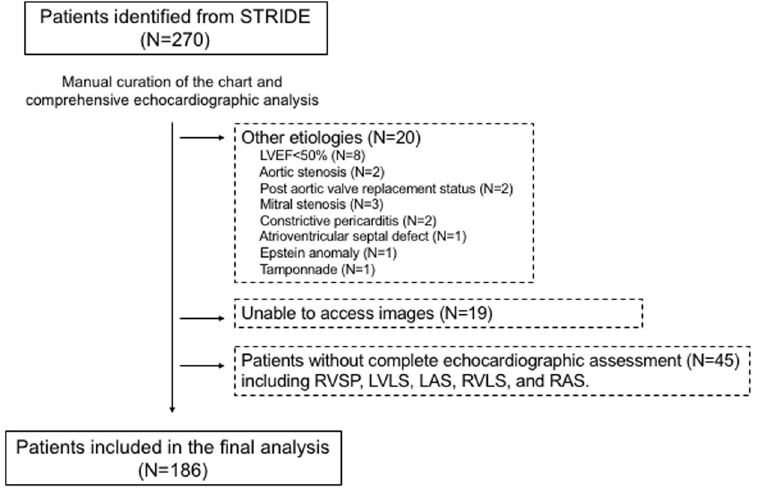
Figure 1. Flow chart of patients in the study. Patients were identified using Stanford Translational Research Integrated Database Environment (STRIDE). Manual curation of the chart was performed to confirm a diagnosis of heart failure for hospitalization. Echocardiographic images of each patient were reviewed to exclude other etiologies and comprehensive echocardiographic assessment was performed. If either one of the echocardiographic parameters of LVLS, LAV, LAS, RVLS, RAS or RVSP was not measurable due to the poor 2D image quality or the quality of tricuspid regurgitation signal. LAV, left atrial volume; LAS, left atrial strain; LVLS, left ventricular longitudinal strain; RAS, right atrial strain; RVLS, right ventricular longitudinal strain; RVSP, right ventricular systolic